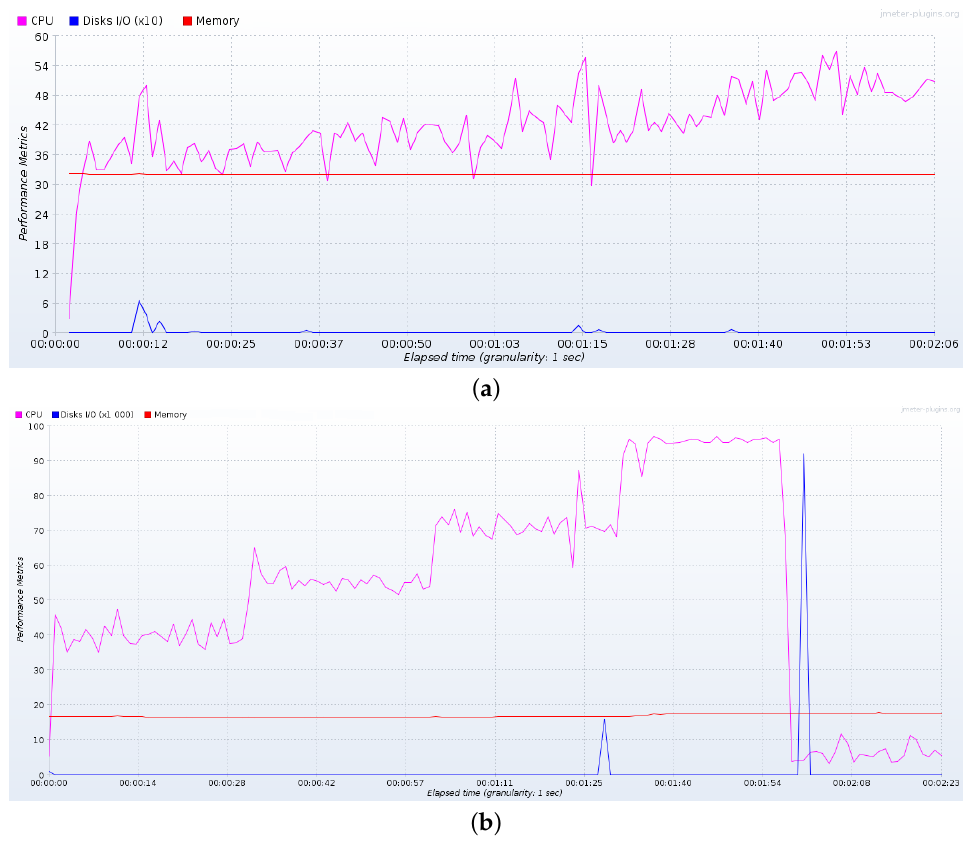
Figure 12. Distributed deployment: Resource utilization reported by ( a ) MongoDB and ( b ) the workers for the task: “10—Tasks Completed by Emergency”.